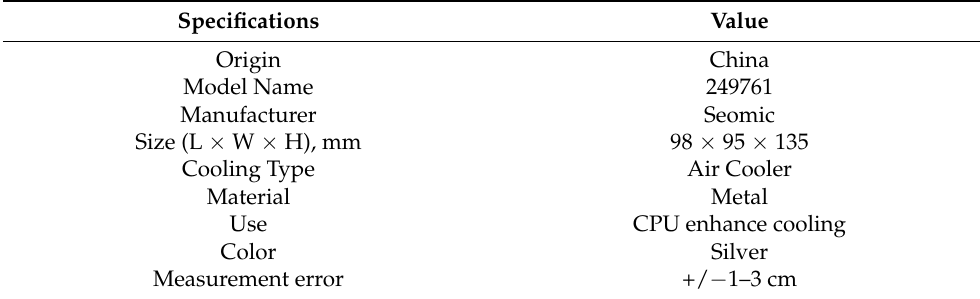
Figure 2. Modified PV panel with integrated fanless heat pipe sink. Table 1. Specifications for the fanless heat pipe sink